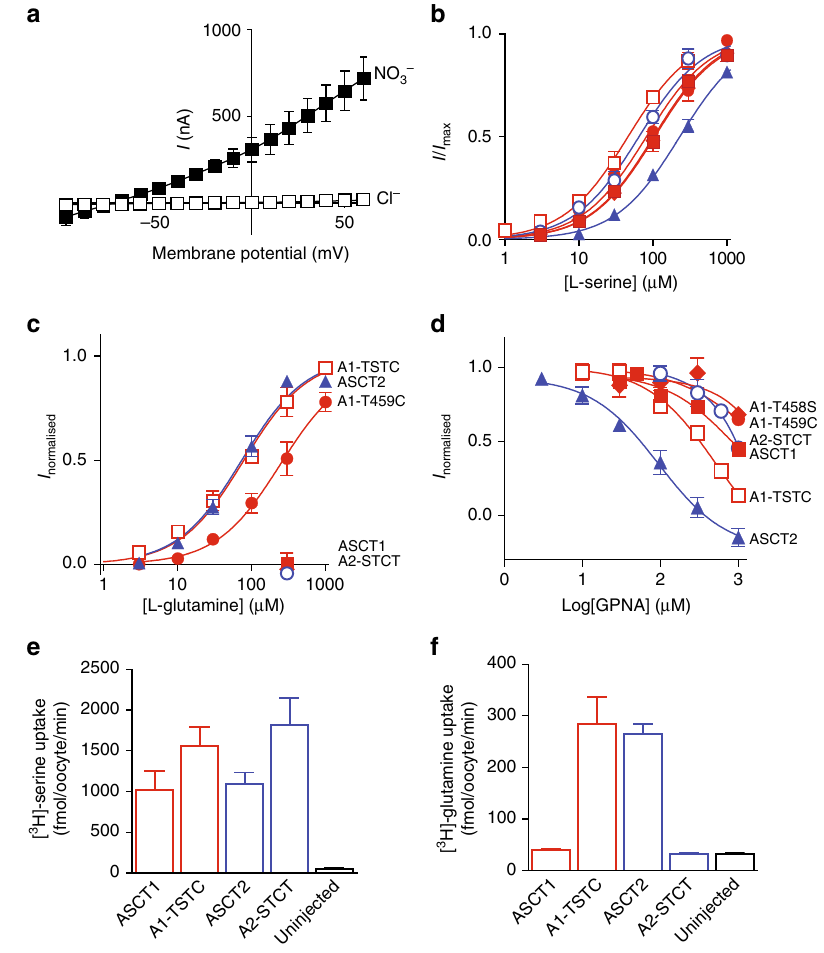
Fig. 2 Mutations in ASCT1 and ASCT2 affect substrate and inhibitor selectivity a Current – voltage relationships elicited by 300 µ M L-serine in Cl − - containing buffer (open squares) and NO 3 − -containing buffer (closed squares), at pH 7.5 in wild-type ASCT1. Concentration – response curves are shown for L-serine b and L-glutamine c in ASCT1 (red, closed squares), ASCT2 (blue, closed triangles), A1-T458S (red diamonds), A1-T459C (red, closed circles), A1-T458S/T459C (red, open squares) and A2-S481T/C482T (blue, open circles) at+60 mV. As L-glutamine concentration – response curves for ASCT1, A1-T458S and A2-S481T/C482T was not determined, data were normalised to the predicted maximal current for L-serine for each transporter. d Concentration – response curves are shown for GPNA in ASCT1 (red, closed squares), ASCT2 (blue, closed triangles), A1-T459C (red, closed circles), A1- T458S (red diamonds), A1-T458S/T459C (red, open squares) and A2-S481T/C482T (blue, open circles). GPNA was co-applied with an EC 50 value of L- serine for the respective transporters and normalised to the current generated by the application of L-serine alone. L-[ 3 H]serine e and L-[ 3 H]glutamine f uptake into oocytes expressing wild-type and mutant ASCT1 (red), ASCT2 (blue) transporters and uninjected control oocytes (black). Oocytes were incubated in Cl − -containing buffer with 10 µ M L-[ 3 H]substrate at room temperature, pH 7.5 for 10 min. Values presented are mean ± S.E.M, ( n ≥